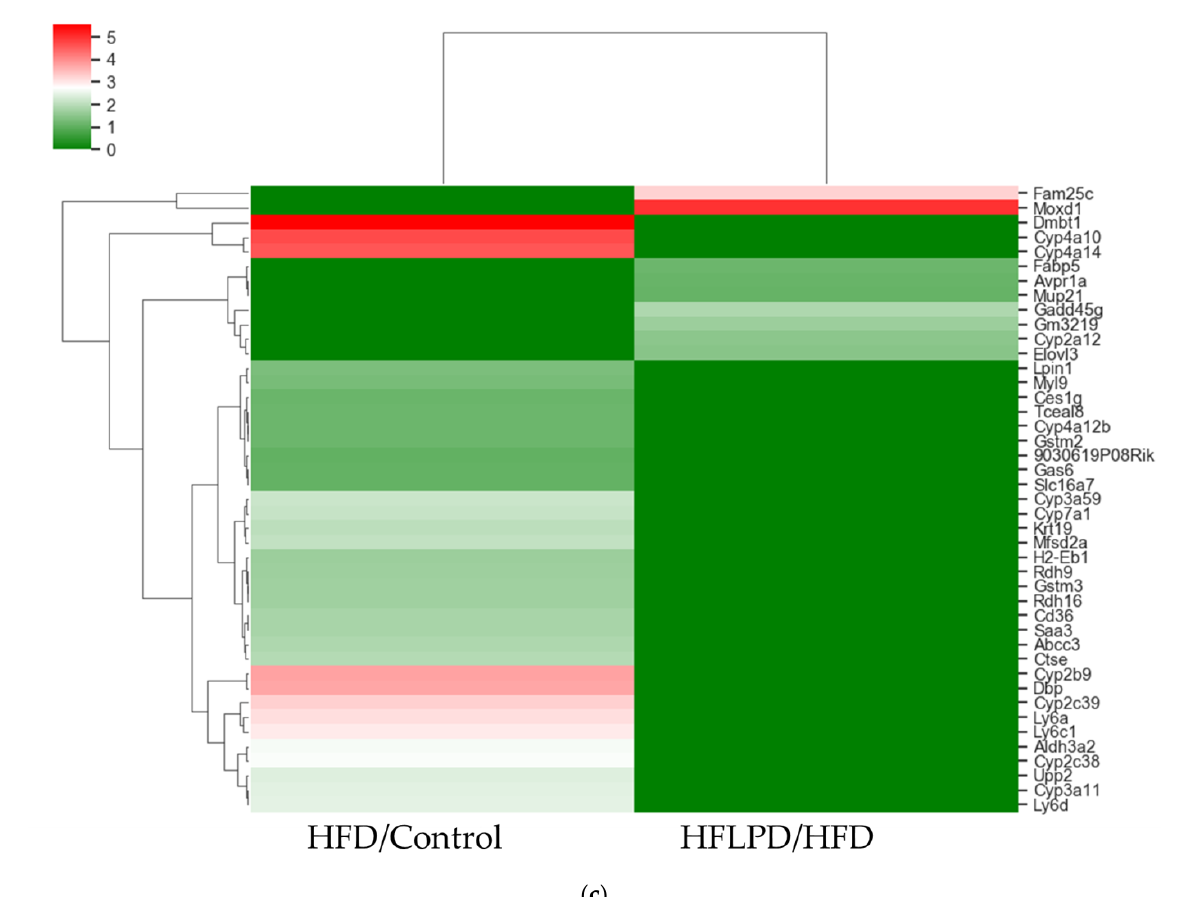
Figure 3. Contraregulation of identified DEGs in the liver tissue between HFD- and HFLPD-fed animals. In total, 43 DEGs were identified in both HFD- and HFLPD-fed animals that were contraregulated. ( a ) Venn diagram of the DEGs identified among HFD- and HFLPD-fed animals. ( b ) KEGG pathway of the DEGs. ( c ) Heat map views of the DEGs detected between HFD and HFLPD animals. Table 2. Functional annotations of differentially expressed genes in HFD-fed animals compared to Table 1. Contraregulation of DEGs in the liver of HFD- and HFLPD-fed mice. control